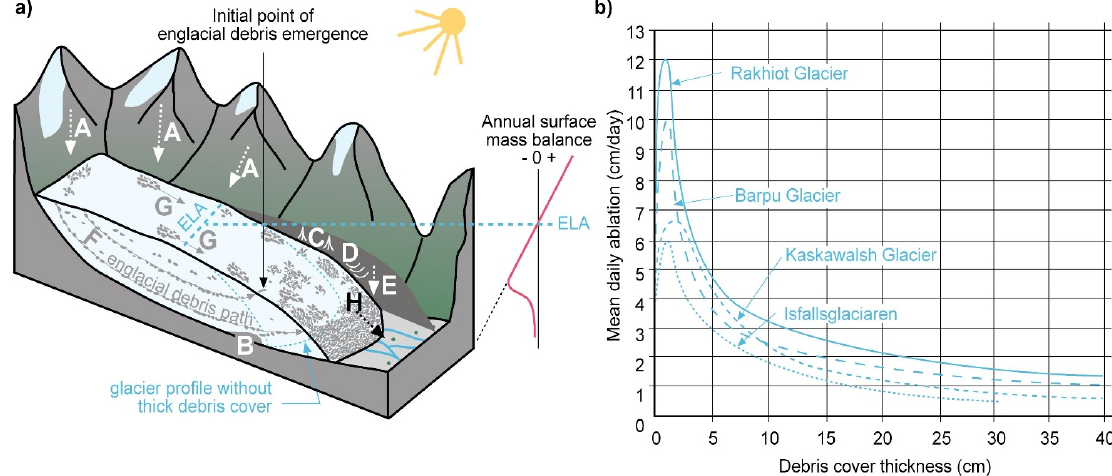
Figure 4. ( a ) Schematic diagram displaying debris supply processes, debris fluxes and debris features on DCGs: rock falls and landslides from surrounding walls and slopes (A); basal thrusting (B); debris flows (C), solifluction (D) and rock falls (E) from lateral moraines; debris transport (within (F) and upon the glacier (G)), debris concentration near the glacier terminus and eventual debris transfer to the glacier foreland (H); a debris cover surpassing a critical thickness has a significant effect on the annual surface mass balance of a glacier by reducing the ablation and consequently the ice discharge and length reduction (redrawn from [21,85–86]; ( b ) relationship between debris cover thickness and measured mean daily ablation on different DCGs (adapted from [88]).